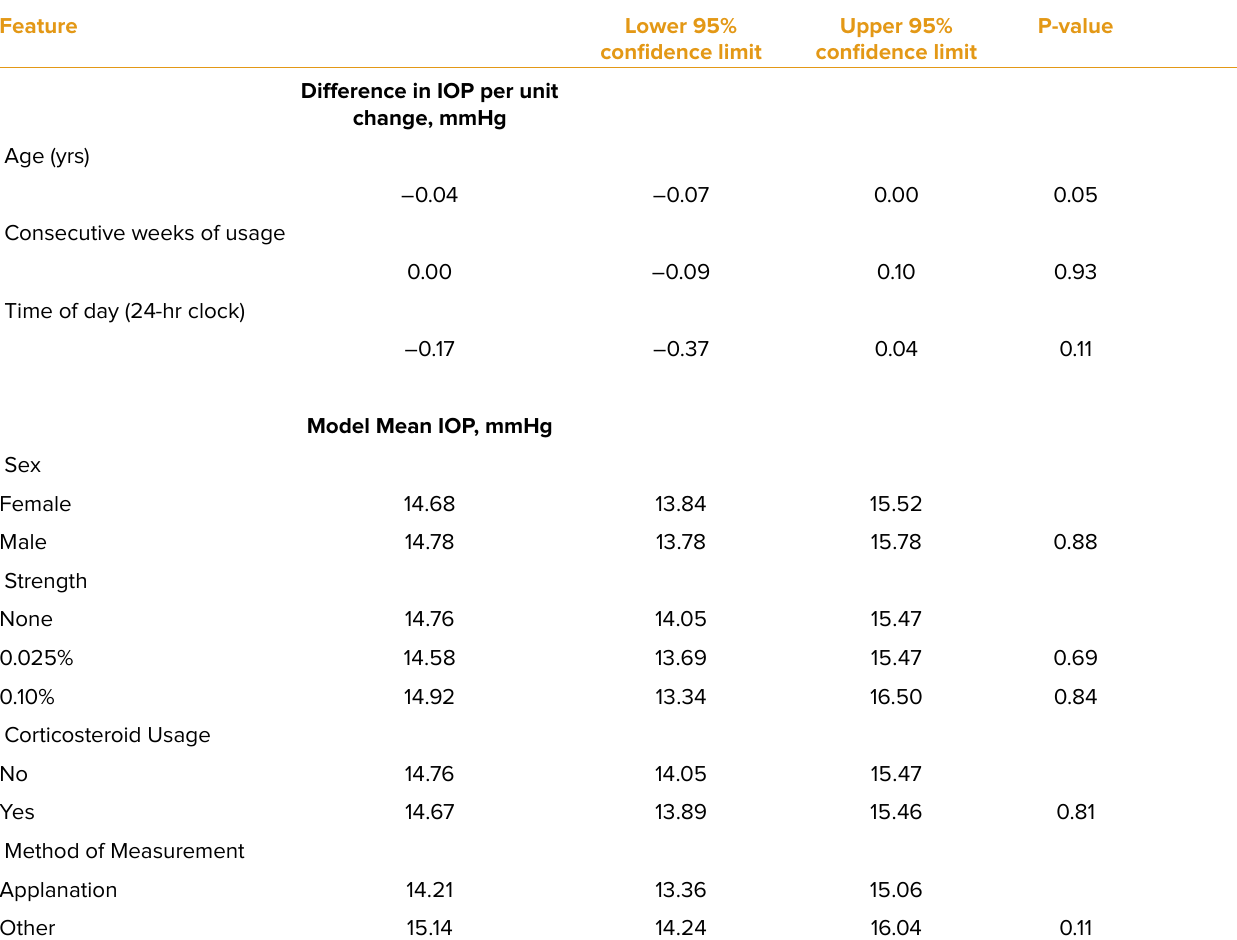
Table 4. Univariate regression analysis of the association of features and IOP for all IOP